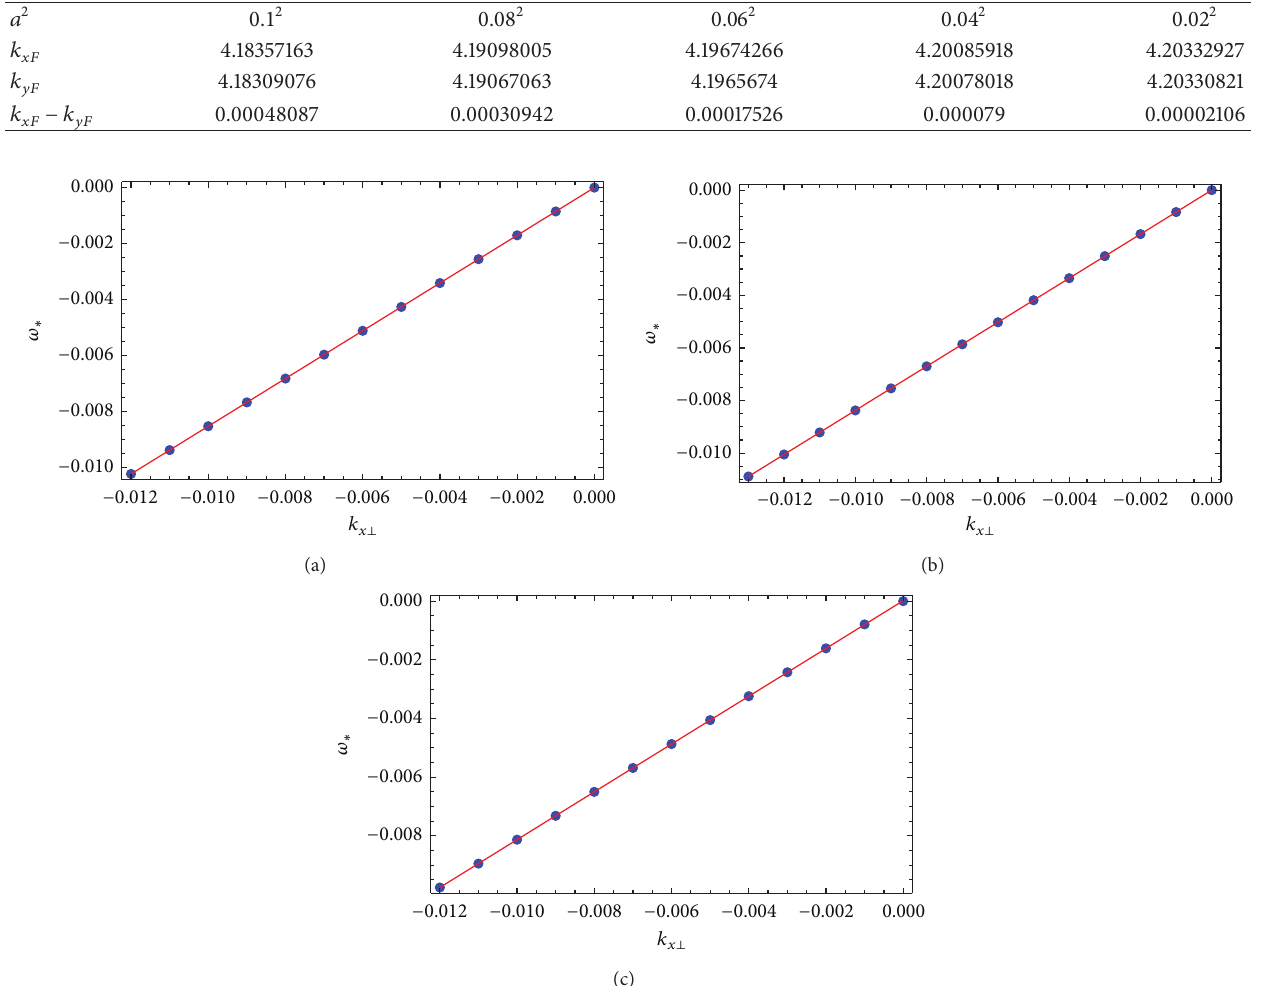
Figure 4: The dispersion relation between 𝑘 𝑥⊥ and 𝜔 ∗ for 𝑎 2 = 0.01 (a), 𝑎 2 = 0.04 (b), and 𝑎 2 = 0.09